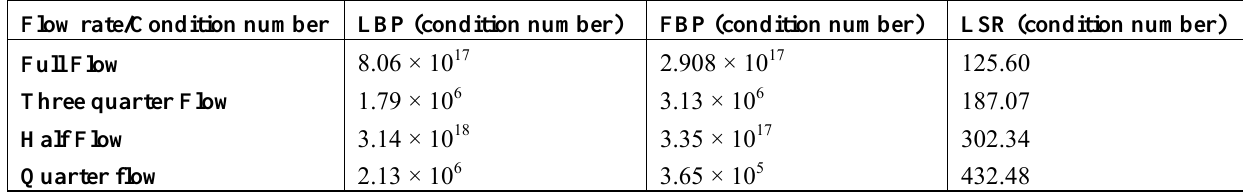
Table 1. Images condition number for different types of